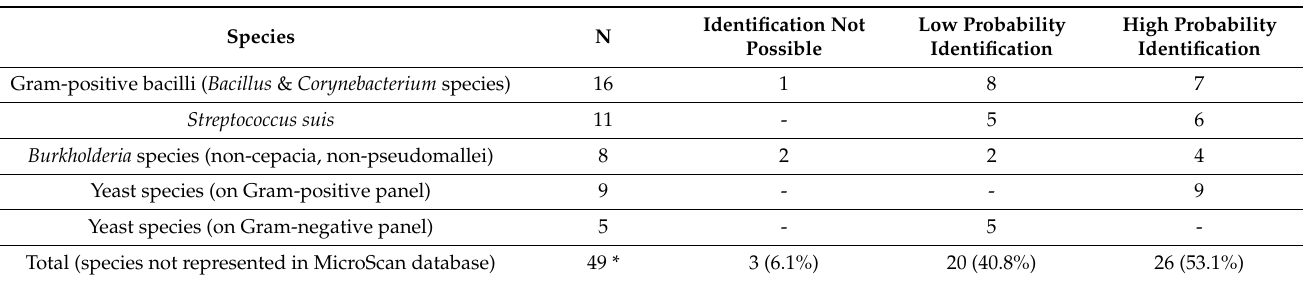
Table 3. Overall performance of the MicroScan Gram-negative and Gram-positive panels for micro-organisms not represented in the MicroScan database. All identifications by the MicroScan system are by definition incorrect because the species are not represented in the database. The expected result for these species is “identification not possible”. N = total number of isolates tested. Overall, * 44 different isolates were tested, five of which on both the Gram-positive as the Gram-negative